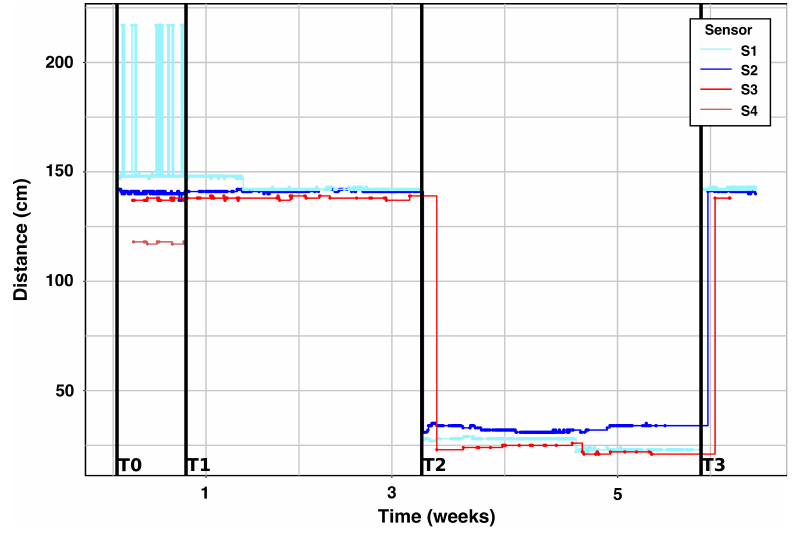
Figure 10. Data collection of 4 sensors placed into a 1100 L test bin